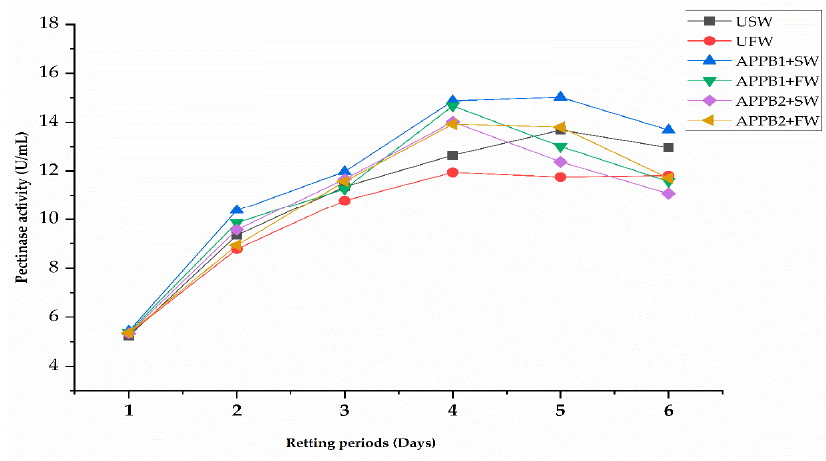
Figure 5. Pectinase enzyme activity during non-sterile kenaf retting using alkalophilic pectinolytic bacteria combined with retting solvents.